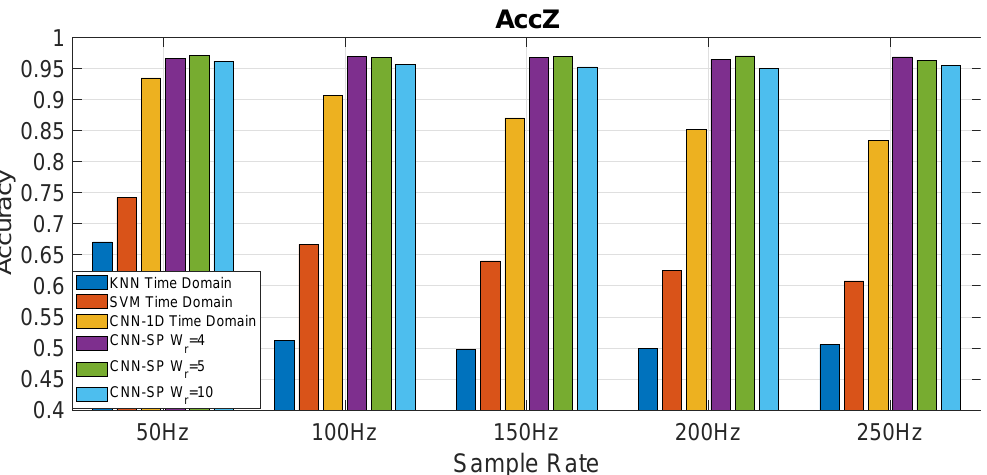
Figure 14. Comparison of the accuracy among the spectrogram CNN approach (CNN-SP) proposed in this paper (for different window sizes), the CNN directly applied to the time domain representation (CNN-1D), and the shallow machine learning techniques (SVM, KNN) applied to the data of the Accelerometer in the Z direction